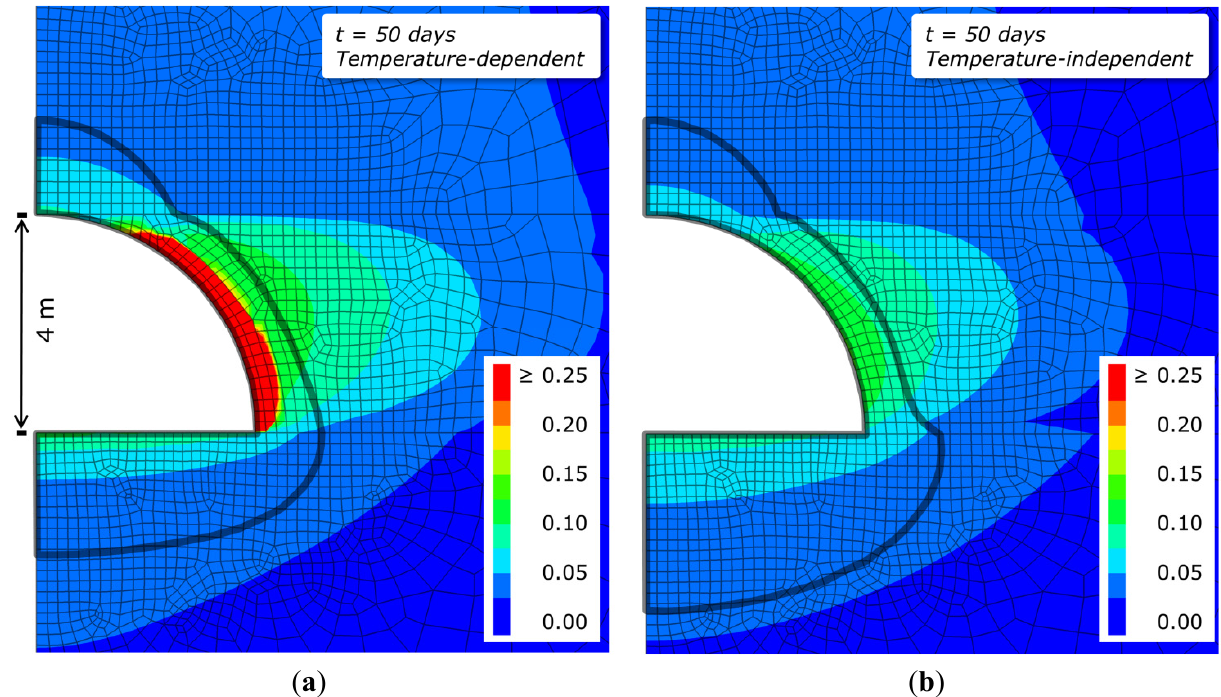
Figure 8. Distribution of total displacements of surrounding rocks in the UCG reactor vicinity after stepwise reactor zone excavation with ( a ) temperature-dependent properties and ( b ) temperature-independent material properties after 50 days of simulation. The grey solid line represents the 200 °C